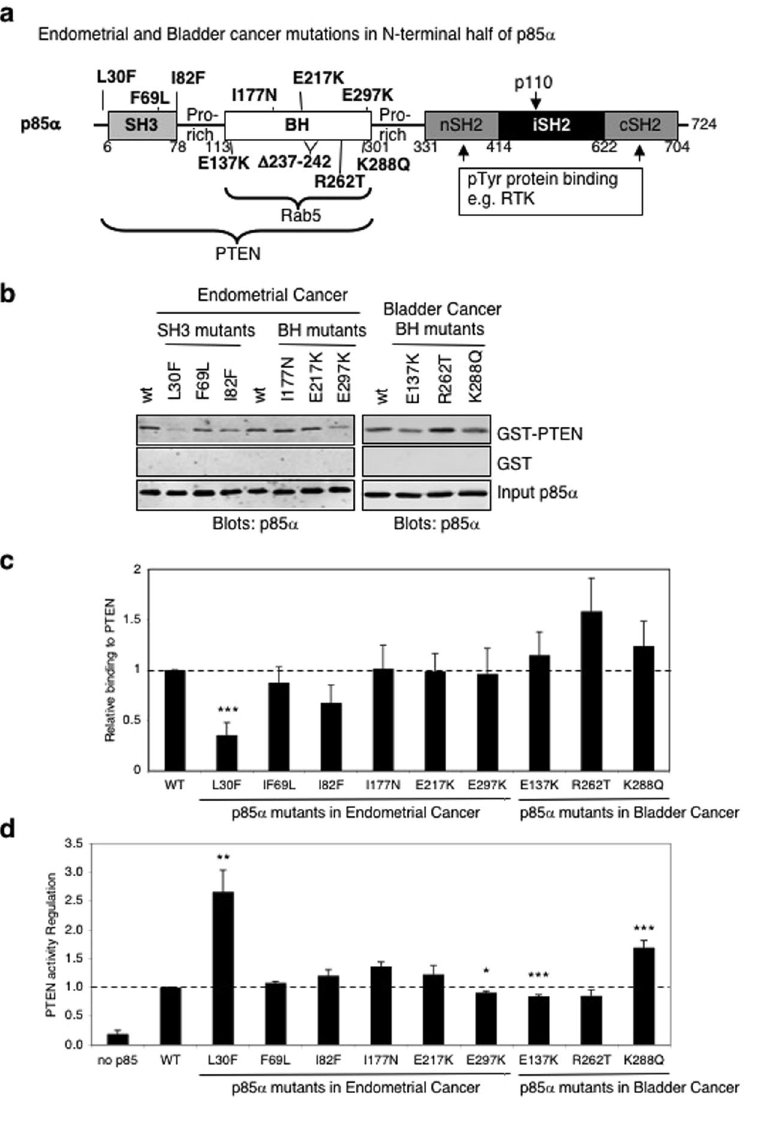
Figure 1. Binding and regulation of PTEN by p85 α patient-derived SH3 and BH domain mutants. ( a ) Schematic representation of p85 α with the locations of endometrial and bladder cancer-associated mutations within the SH3 and BH domains shown. ( b ) Pull-down assays for p85 α mutants binding to PTEN. Input of p85 α is 4% of the amount used in the pull-down binding experiments. Data representative of at least 9 independent experiments. Full-length images of the cropped blots are in Supplementary Fig. S4. ( c ) Quantification of binding assay results from panel b. Mean ± SEM. *** P < 0.001 as compared to wild type p85 α . ( d ) The ability of each p85 α mutant protein to regulate PTEN was determined using a PTEN lipid phosphatase activity assay. Mean ± SEM for 4–5 independent experiments. *** P < 0.001, ** P < 0.01, * P < 0.05 as compared to wild type p85 α